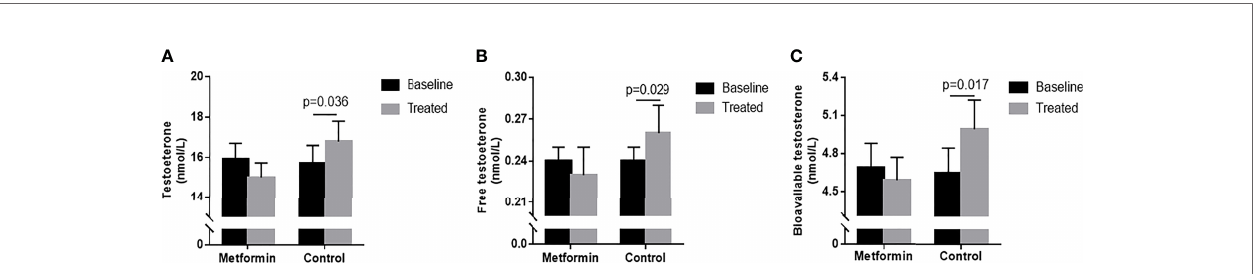
FIGURE 1 | (A – C) TT, FT and Bio-T levels at baseline and endpoint in metformin and control group. Data are mean ±